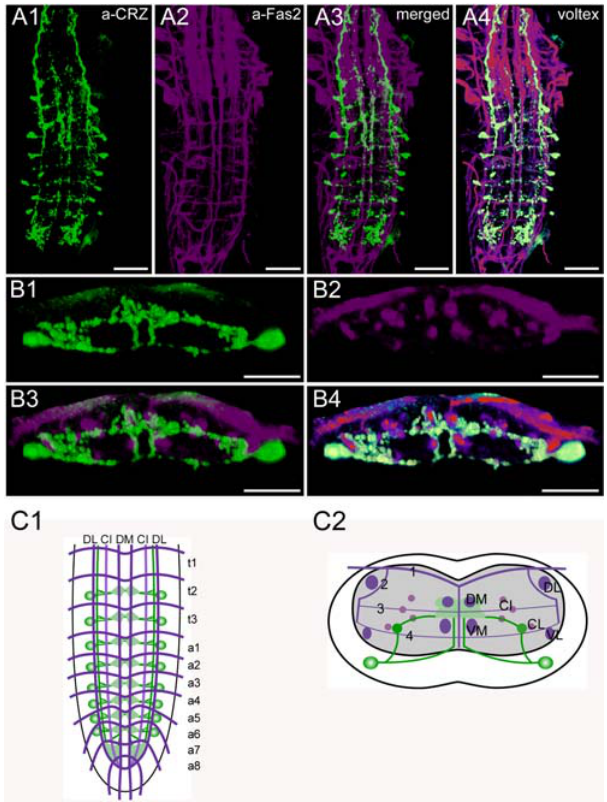
Figure 4. Morphology of CCAP neurons. Mapping of Ccap -GAL4xUAS- cd8.gfp expressing neurons in whole-mount preparations of the thoracic and abdominal neuromeres of L3 larva in the Fas2 landmark system. A) Dorsal view. B) Transversal view at the height of neuromere a3. C) Idealized dorsal scheme. D) Idealized transverse scheme. Scale bars: 50 m m in A ), 25 m m in B ). Marker protein expression is shown in green, Fas2 in magenta.